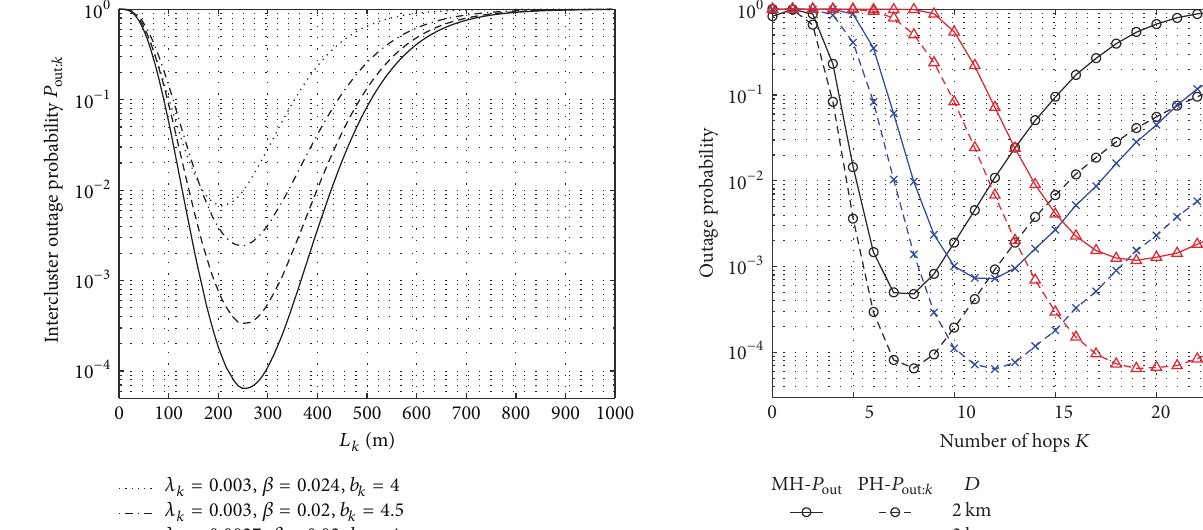
Figure 5: Intercluster outage probability 𝑃 out :𝑘 versus 𝐿 𝑘 . Figure 6: